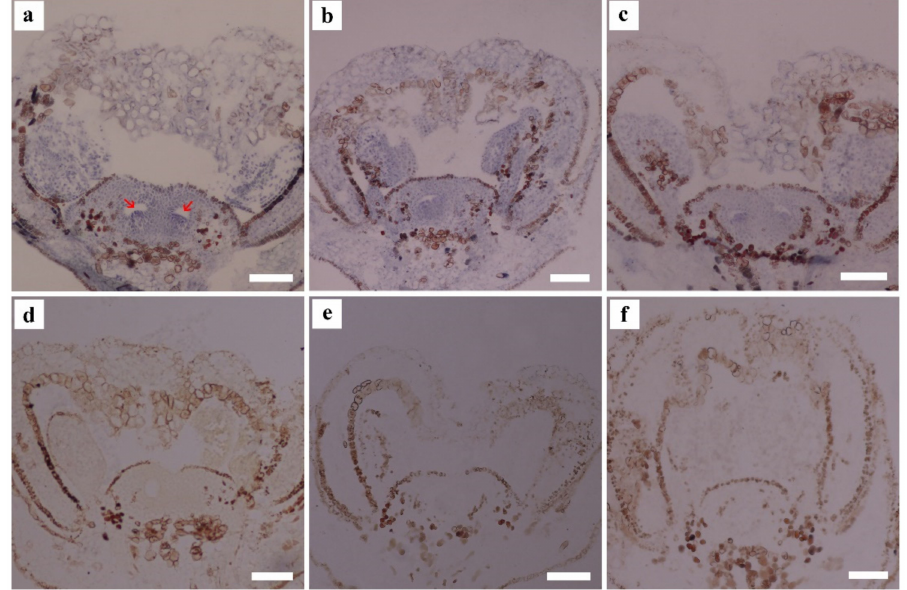
Figure 6. In situ hybridization of VvAG2 , VvSEP3 and VvAGL11 at the stage of ovule primordium formation. ( a ) In situ hybridization of VvAG2 . ( b ) The hybridization signal of VvSEP3 . ( c ) In situ hybridization of VvAGL11 . The negative control of VvAG2 ( d ), VvSEP3 ( e ) and VvAGL11 ( f ). Red arrows indicate a hybridization signal. Inflorescence length: 4–5 cm. Scale bars = 200 µ